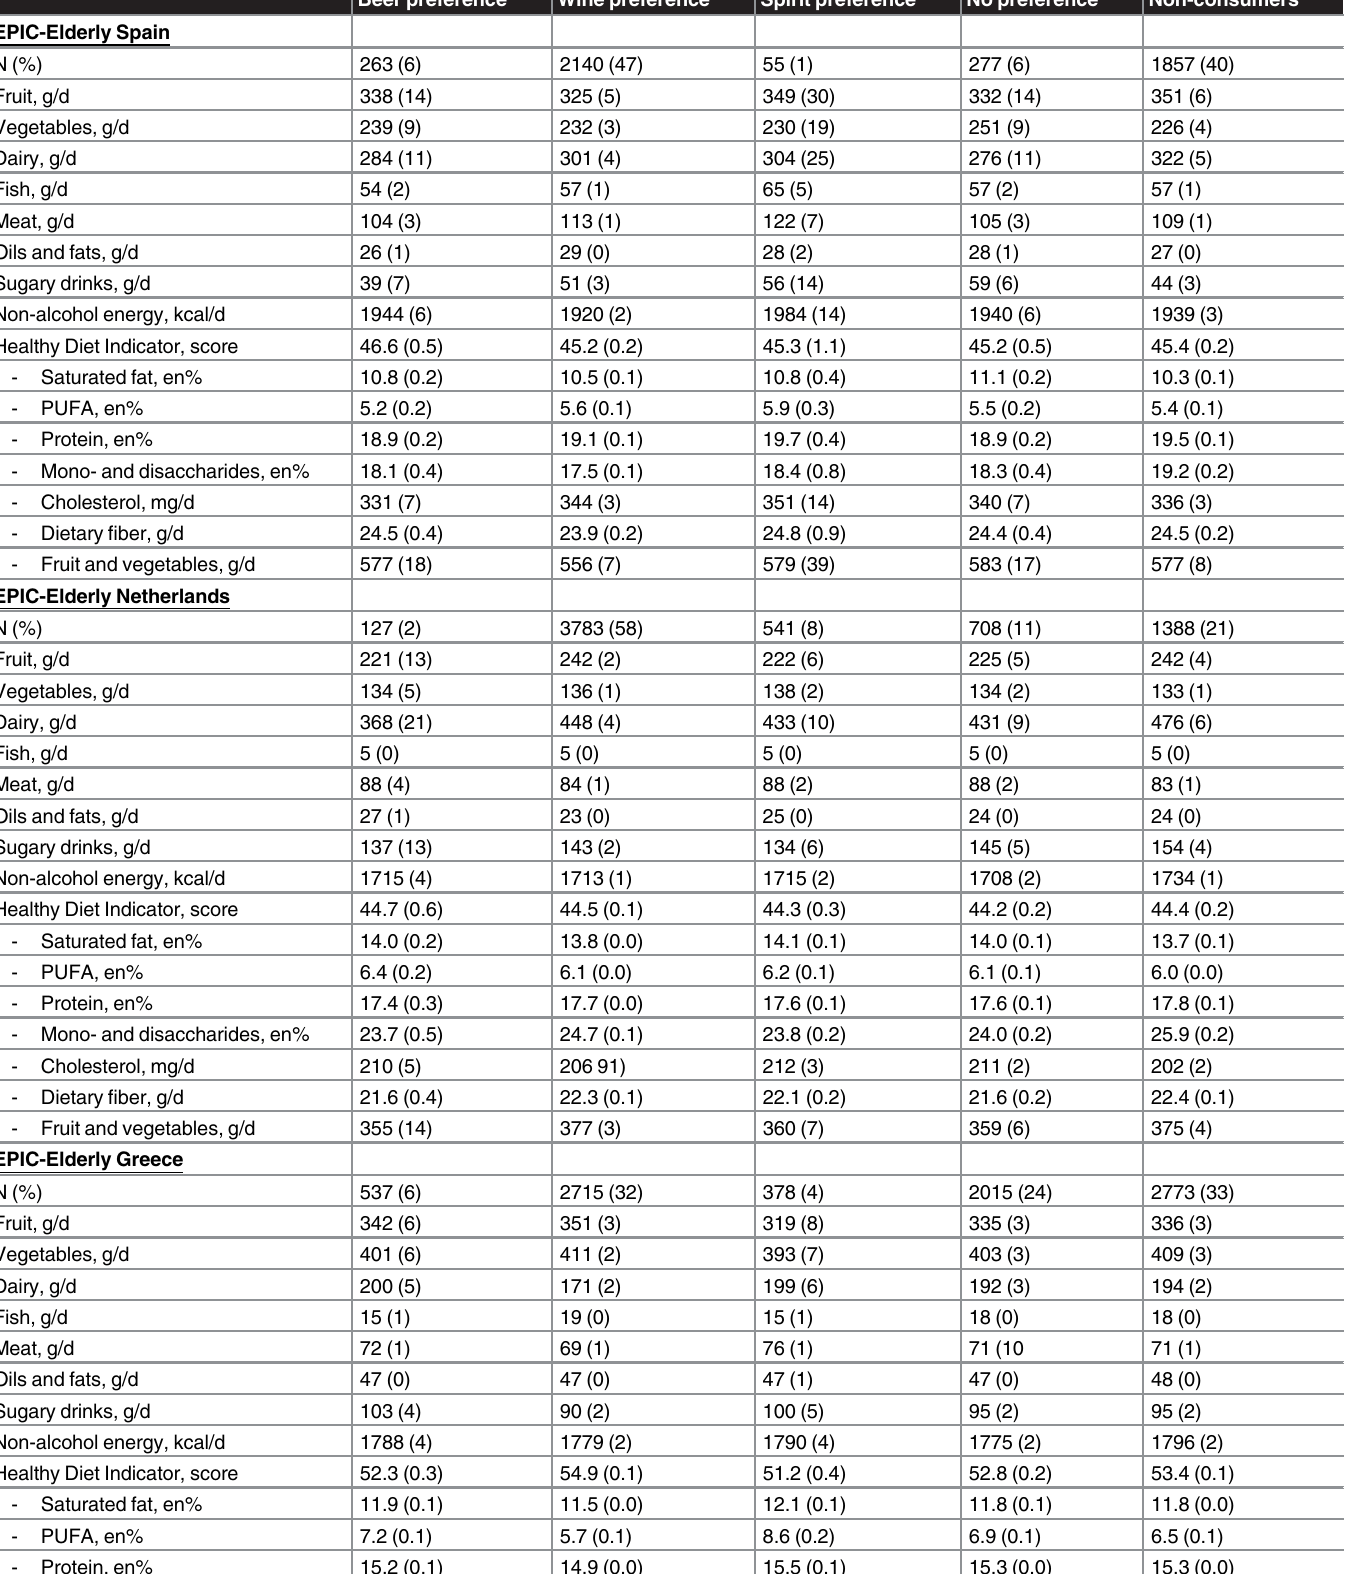
Table 2. Adjusted a food group and nutrient intakes (mean (SE)) across categories of alcoholic beverage